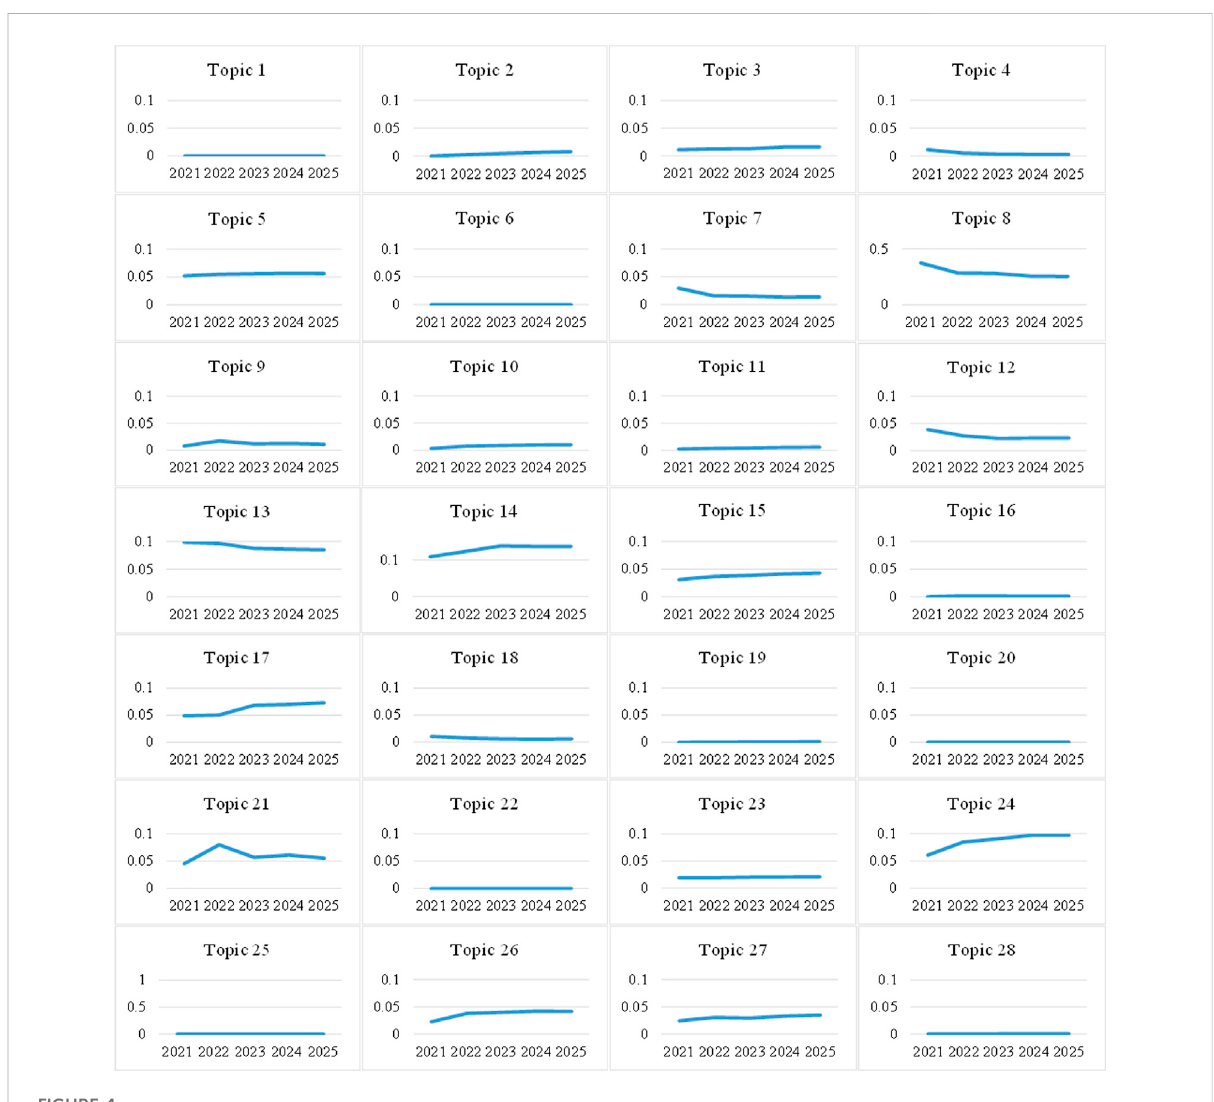
FIGURE 4 The prediction results of the evolutionary trend of technology